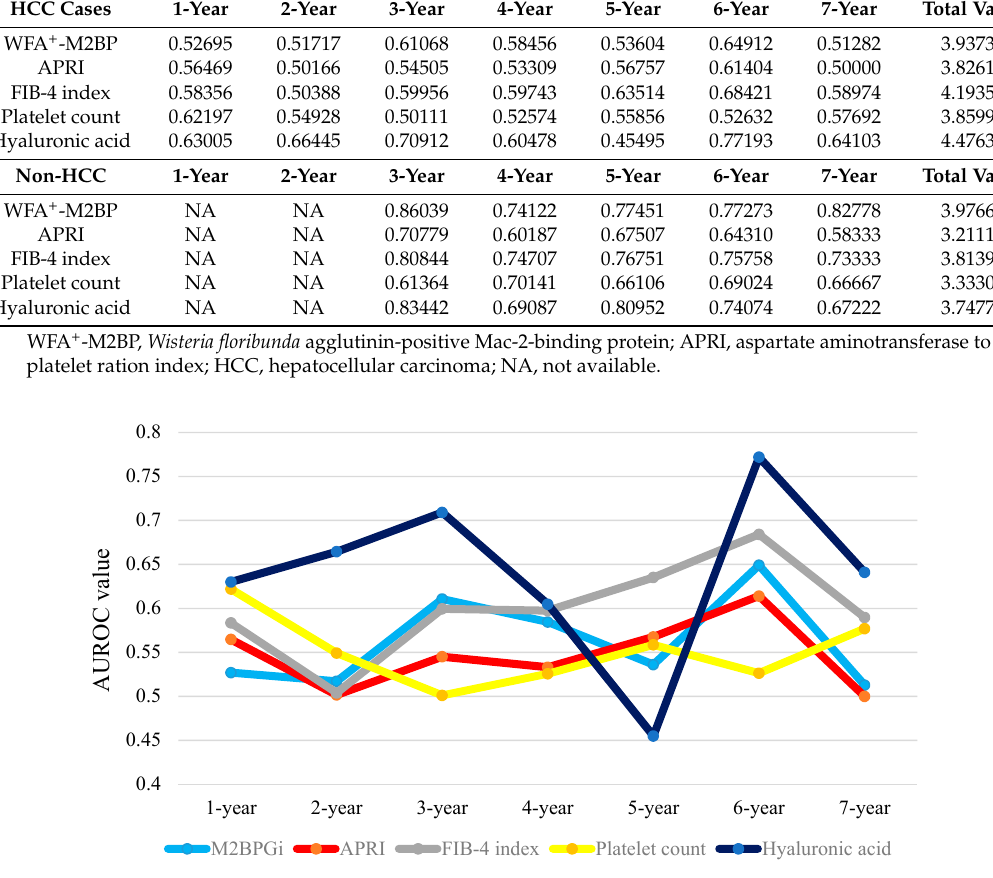
Figure 6. Time-dependent ROC analyses of five liver fibrosis markers (WFA + -M2BP, APRI, FIB-4 index, platelet count and hyaluronic acid) for OS in HCC cases. This figure presents the plots of annual AUROCs of five liver fibrosis markers. The TAAT score indicates total sum of AUROCs in all time-points in each liver fibrosis marker. TAAT score: WFA + -M2BP: 3.93734; APRI: 3.82610; FIB-4 index: 4.19352; platelet count: 3.85990 and hyaluronic acid: